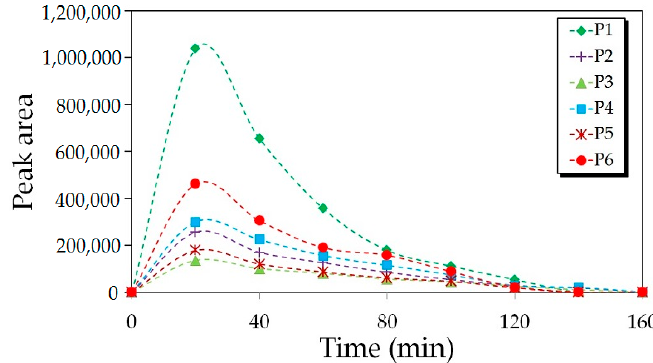
Figure 3. Monitoring the by-products using LC-TOF/MS: 100 mL of solution, 5 V, 0.5 g NaCl, and 200 µ g/L HDZ.